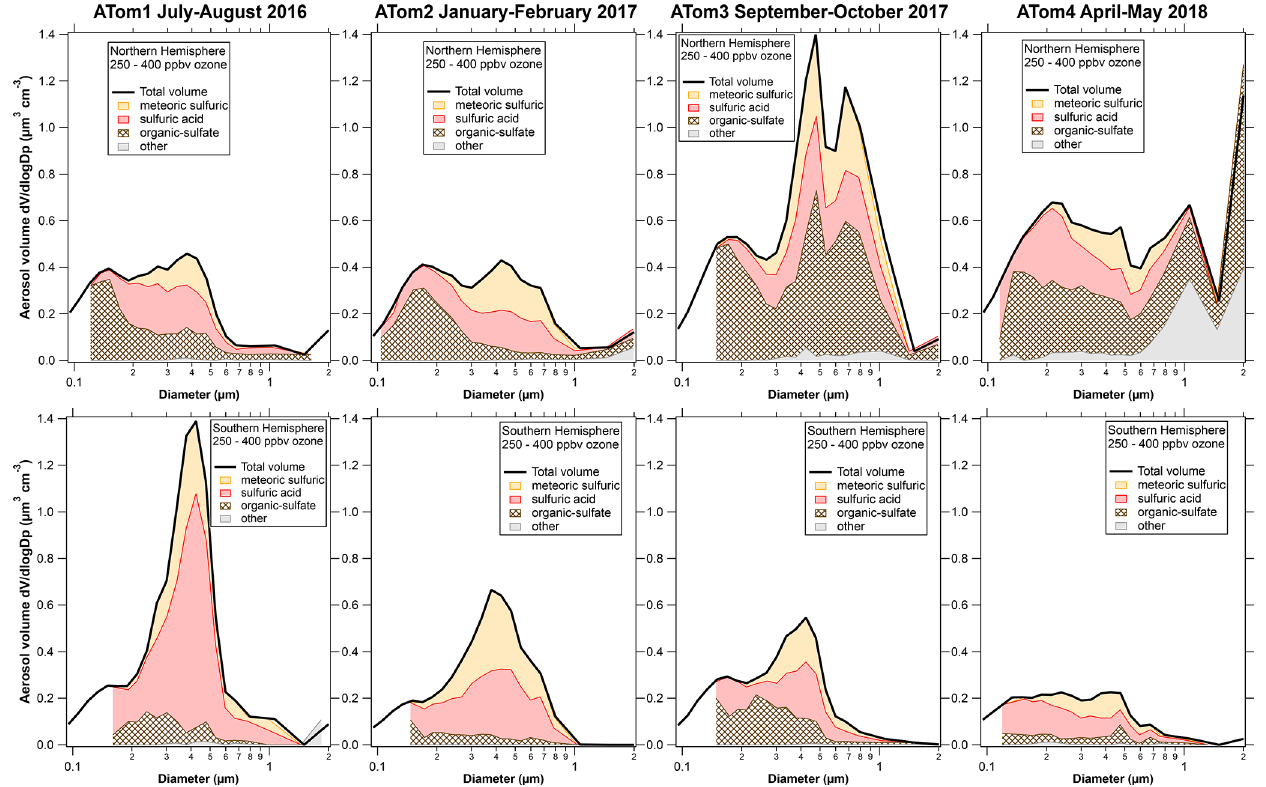
Figure 1. Composition resolved size distributions from the lower stratosphere during the Atmospheric Tomography (ATom) mission. The size distributions from optical particle counter measurements are apportioned at each size into classes of particles based on the PALMS single-particle composition data. The smallest few size bins sometimes had too few particles with PALMS mass spectra to apportion the composition. Sizes in all figures are geometric diameter at low relative humidity, and concentrations are per standard cubic centimeter. Fine structure in some total volume distributions at 0.6µm and larger may be artifacts due to Mie resonances in the optical particle counter; minima near 0.2 or 0.3µm are robust.